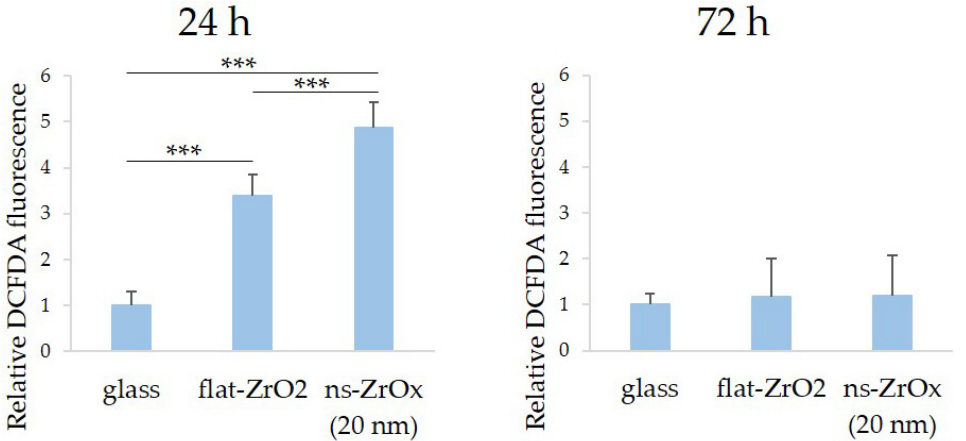
Figure 4. The effect of 20 nm ns-ZrOx substrate on ROS production. bMSCs were cultured on 20 nm ns-ZrOx, flat-ZrO 2 , and glass. After 24 and 72 h, ROS accumulation was measured using a 2 ′ ,7 ′ -dichlorofluorescein (DCFDA) assay. DCFDA fluorescence was normalized to DAPI fluorescence and expressed compared to the cells cultured on glass. *** p ≤ 0.001.